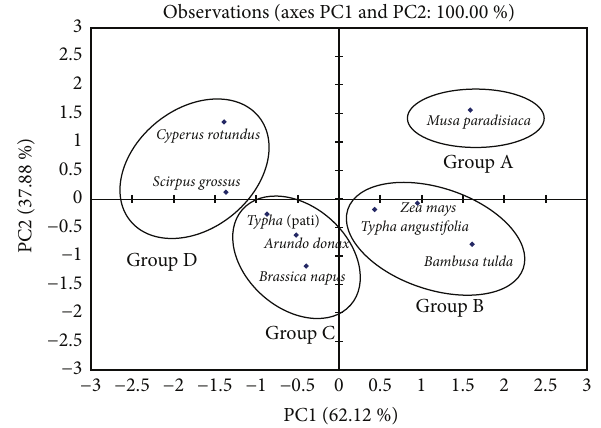
Figure 2: Principal component analysis (PC1 and PC2) of three aquatic plant species compared with other nonwood plant species based on their cellulose and lignin